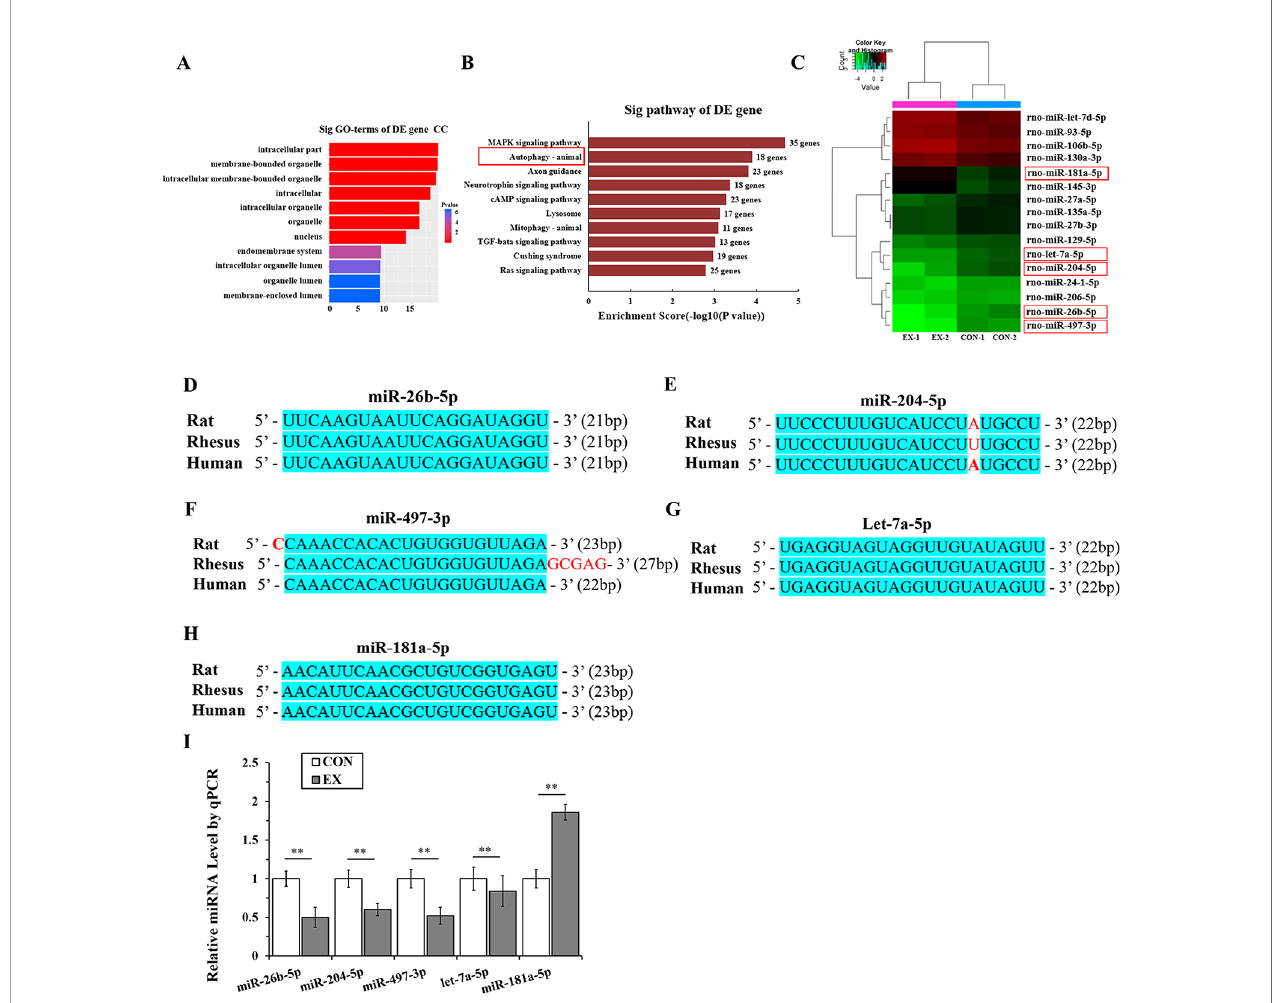
FIGURE 3 | MicroRNAs (miRNAs) targeting the autophagy pathway are signi fi cantly downregulated in physiological cardiac hypertrophy. (A), Gene ontology (GO) analyses showed that most of the miRNA target genes were enriched in cell membrane structure. (B) , Kyoto Encyclopedia of Genes and Genomes (KEGG) analyses. Horizontal axis indicates pathway enrichment score; vertical axis indicates the pathway name. The data label on the right stands for the differentially expressed (DE) gene number associated with the pathway. (C) , Heat map for clustering analysis of miRNA expression data in the CON (n = 2) and EX (n = 2) groups; the miRNAs in the red box are those that bind to the autophagy-related genes in LVH. (D – H) , The sequence homology among rat, rhesus, and human miRNAs; the blue shading area represents the same sequence. (I) , Determination of miRNAs by real-time (RT)-qPCR. Targeted miRNAs were normalized with respect to the U6 levels. ** P < 0.01, EX group (n=16) vs . CON group (n=16). Data are presented as means ± SD. Statistical signi fi cance was evaluated with the two-tailed Student's t